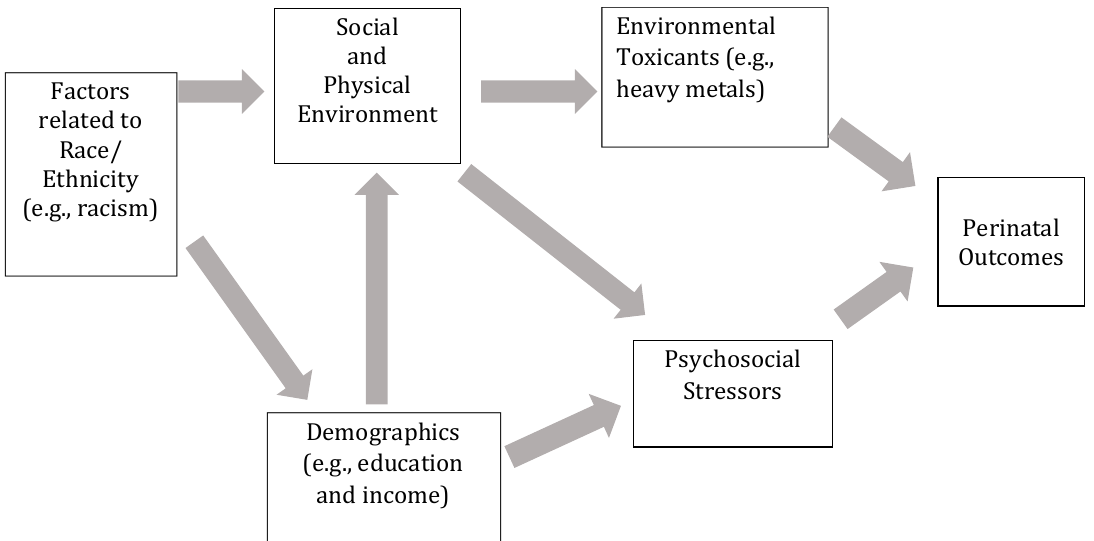
Figure 1. Conceptual model of the relationship between chemical and nonchemical exposures on perinatal outcomes.